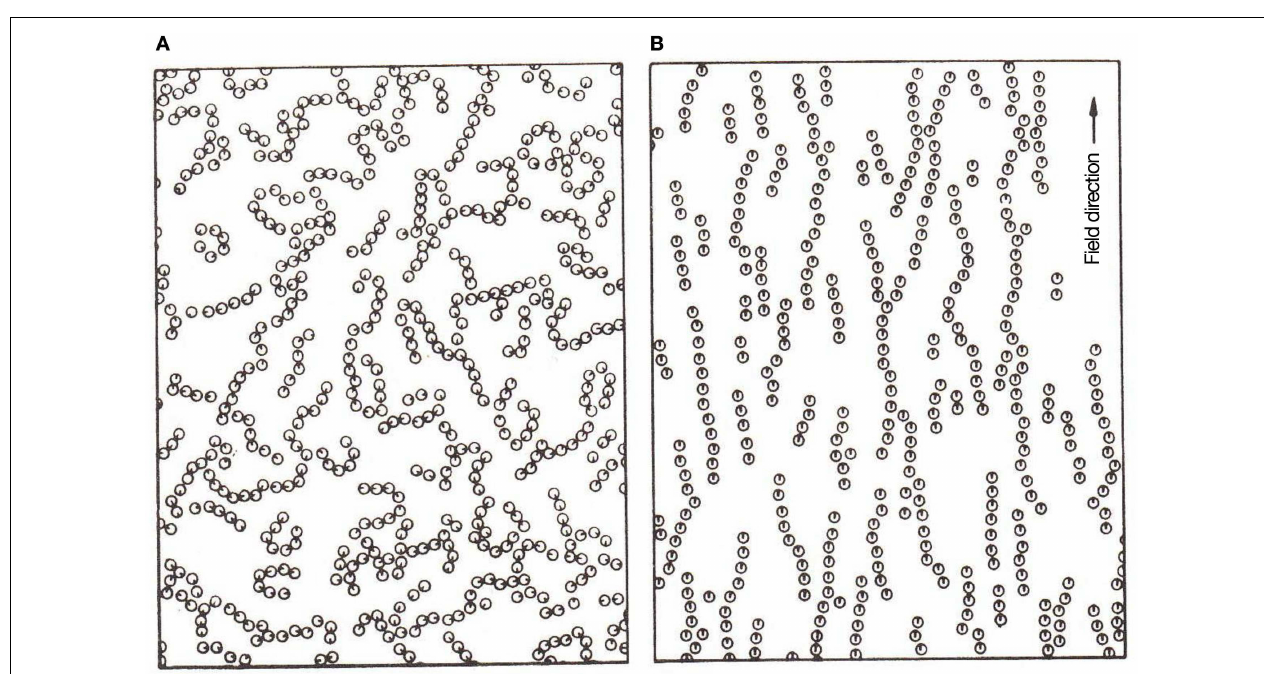
FIGURE 2 | Monte Carlos simulation in 2D: (A) clustering without H-field; (B) chaining under H-field. Reprinted with permission from Chantrell et al., 1982. Copyright 1982, American Institute of Physics; see also Rosensweig, 1997.